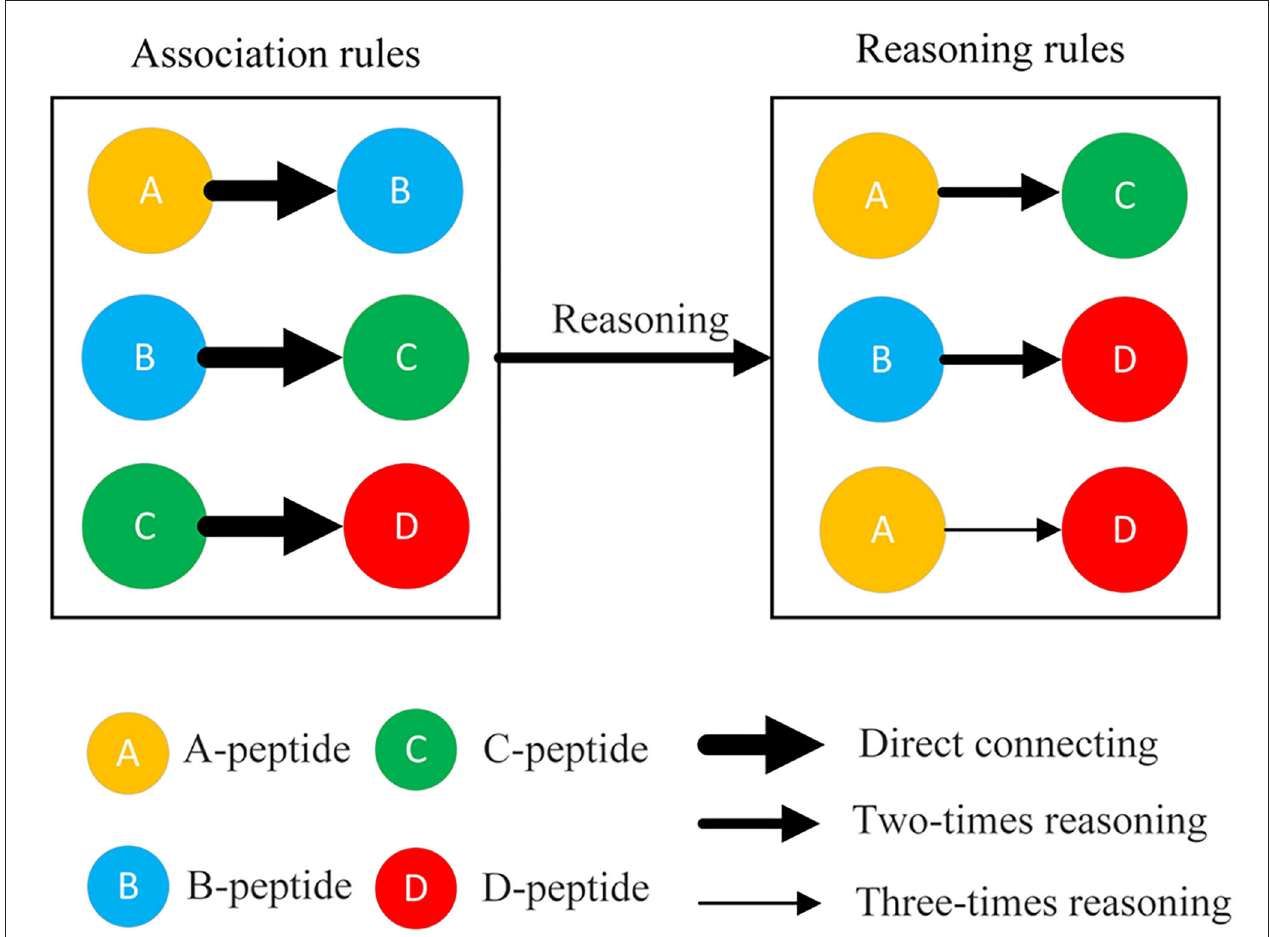
FIGURE 2 | Three rules for matching association. The connections of two peptides were divided into three types: direct connection, twofold reasoning sessions, and threefold reasoning sessions. Direct connection (one-time reasoning): two phosphopeptides/proteins were directly linked. Twofold reasoning: two phosphopeptides/proteins were linked through a different phosphopeptide/protein. Threefold reasoning: two phosphopeptides/proteins were linked through two different